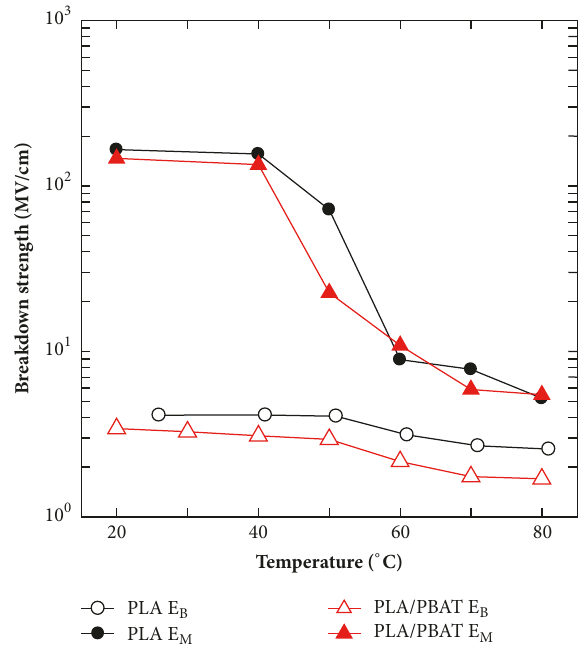
Figure 11: Comparison between measured values of dielectric breakdown strength 𝐸 𝐵 and theoretical values of electromechanical breakdown 𝐸 𝑀 in PLA and